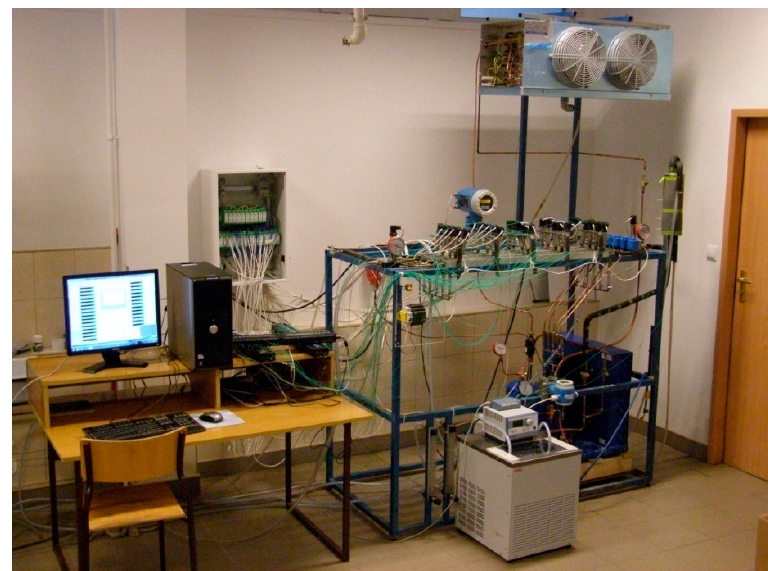
Figure 1. Photo of the apparatus [16,17].